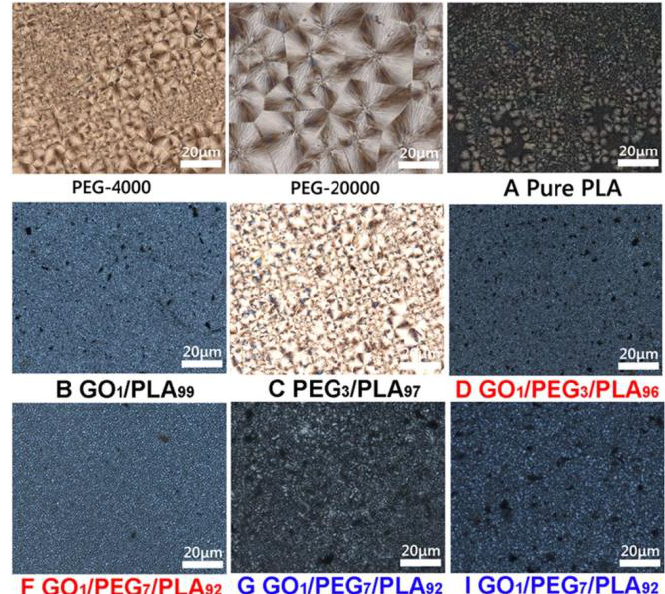
Figure 8. Polarizing microscope (POM) images of PEG, pure PLA, GO/PLA, PEG/PLA, and GO/PEG/PLA multi-phase composites with different component ratio under isothermal crystallization.